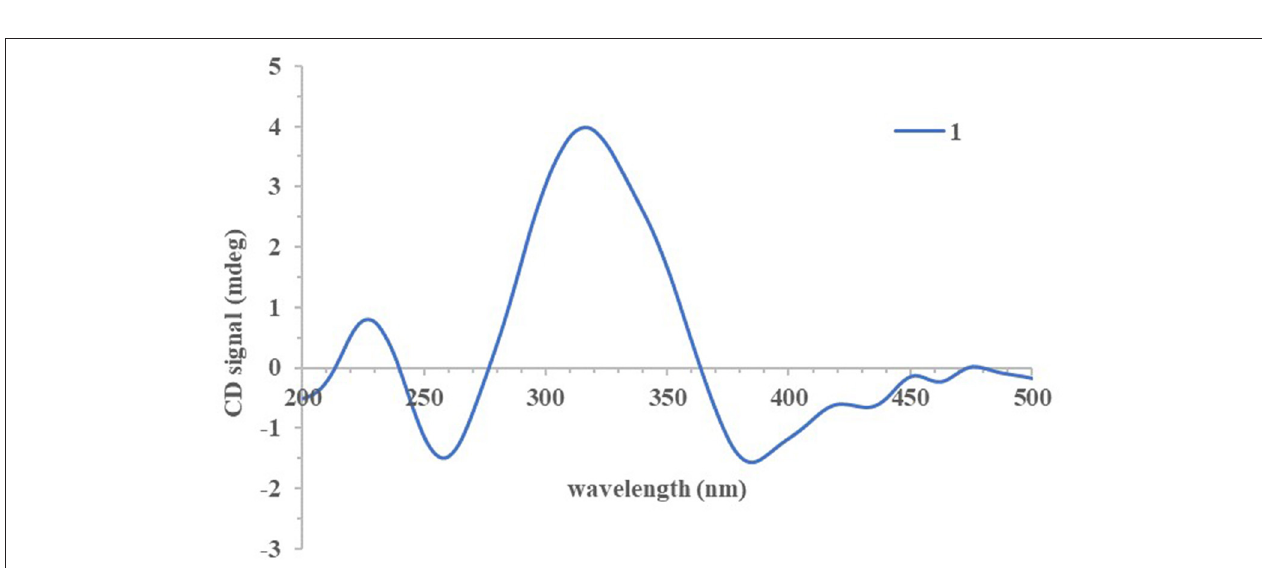
the key nuclear overhauser effect spectroscopy (NOESY) correlations ( Figure 2 , Supplementary Figure S6 ) had obvious